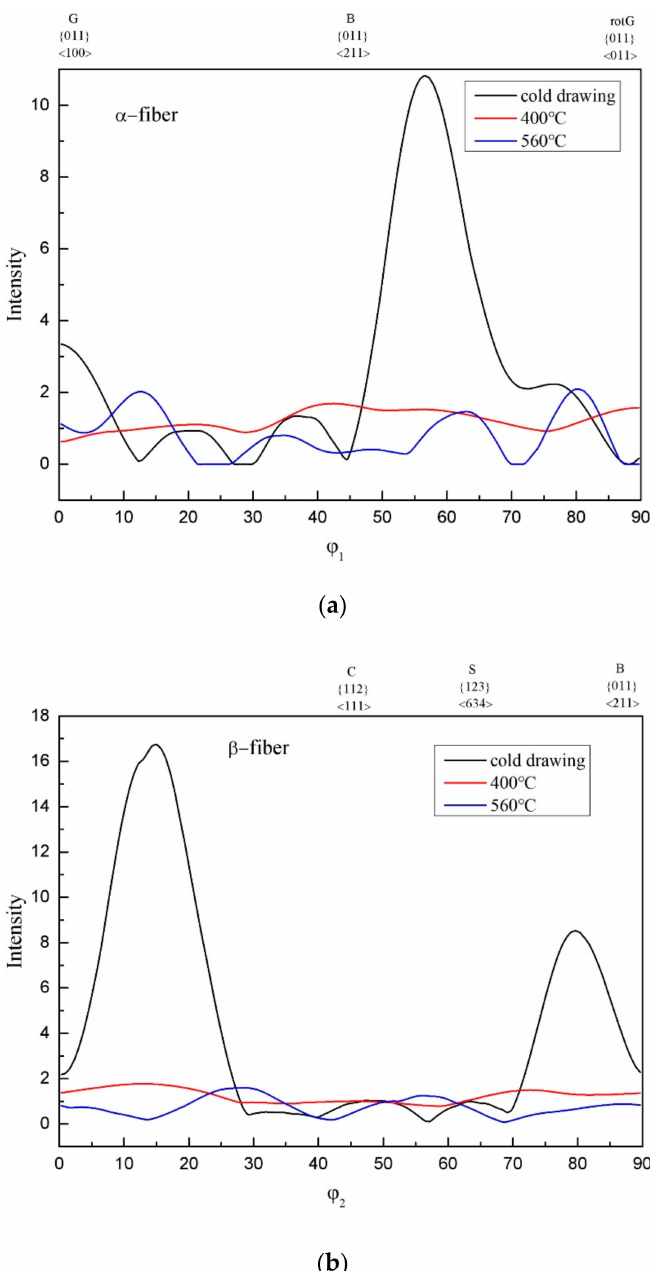
Figure 11. Orientation density of textures of the 5056 aluminum alloy was annealed at different temperatures ( a ) α -fiber; ( b ) β